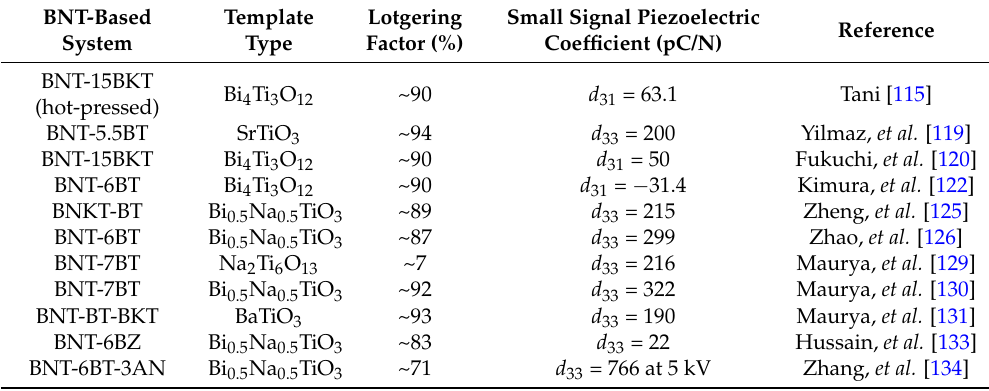
Table 2. Table illustrating the impact of texturing on the piezoelectric coefficients of BNT ‐ based ceramics.